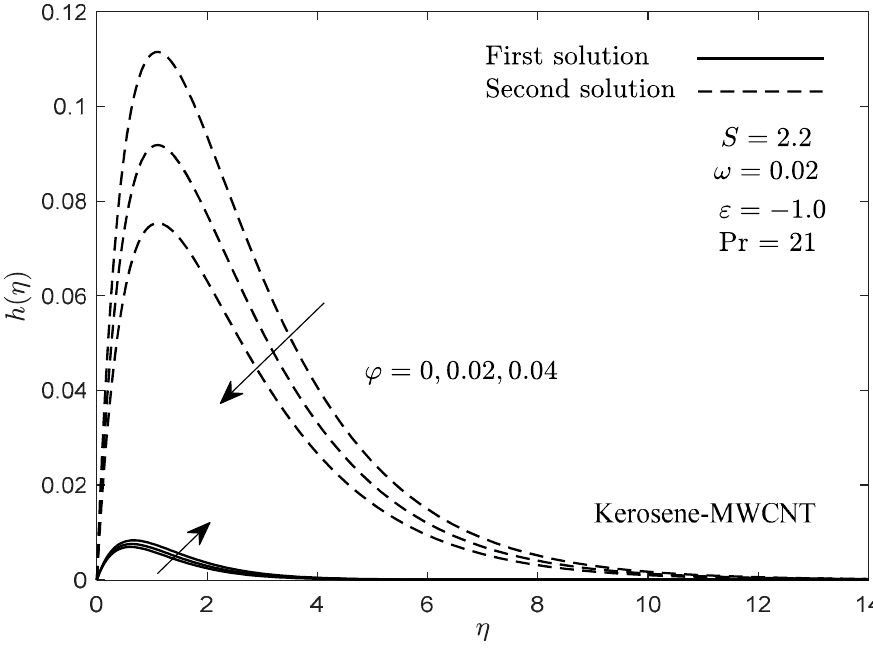
Figure 10. Velocity profiles of 𝑦 -component ℎ(𝜂) for some values of 𝜑 .